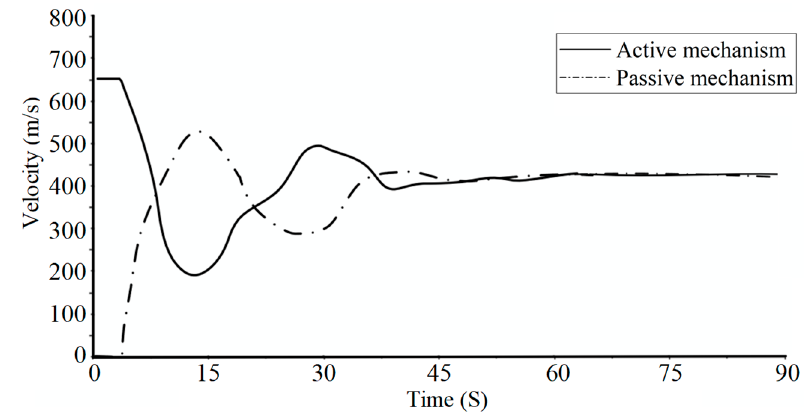
Figure 10. Variation of velocities versus time.